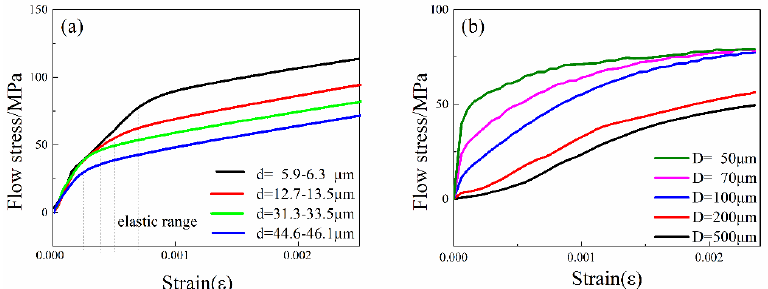
Figure 3. E ff ect of grain and specimen size on flow stress. ( a ) Flow stress curves of di ff erent grain Figure 3. Effect of grain and specimen size on flow stress. ( a ) Flow stress curves of different grain size size specimens with the same diameter (200 µ m); ( b ) Flow stress curves of di ff erent wire diameter specimens with the same diameter (200 μm ); ( b ) Flow stress curves of different wire diameter specimens with the same grain size (5–6.3 µ m). specimens with the same grain size (5 –6.3 μm).